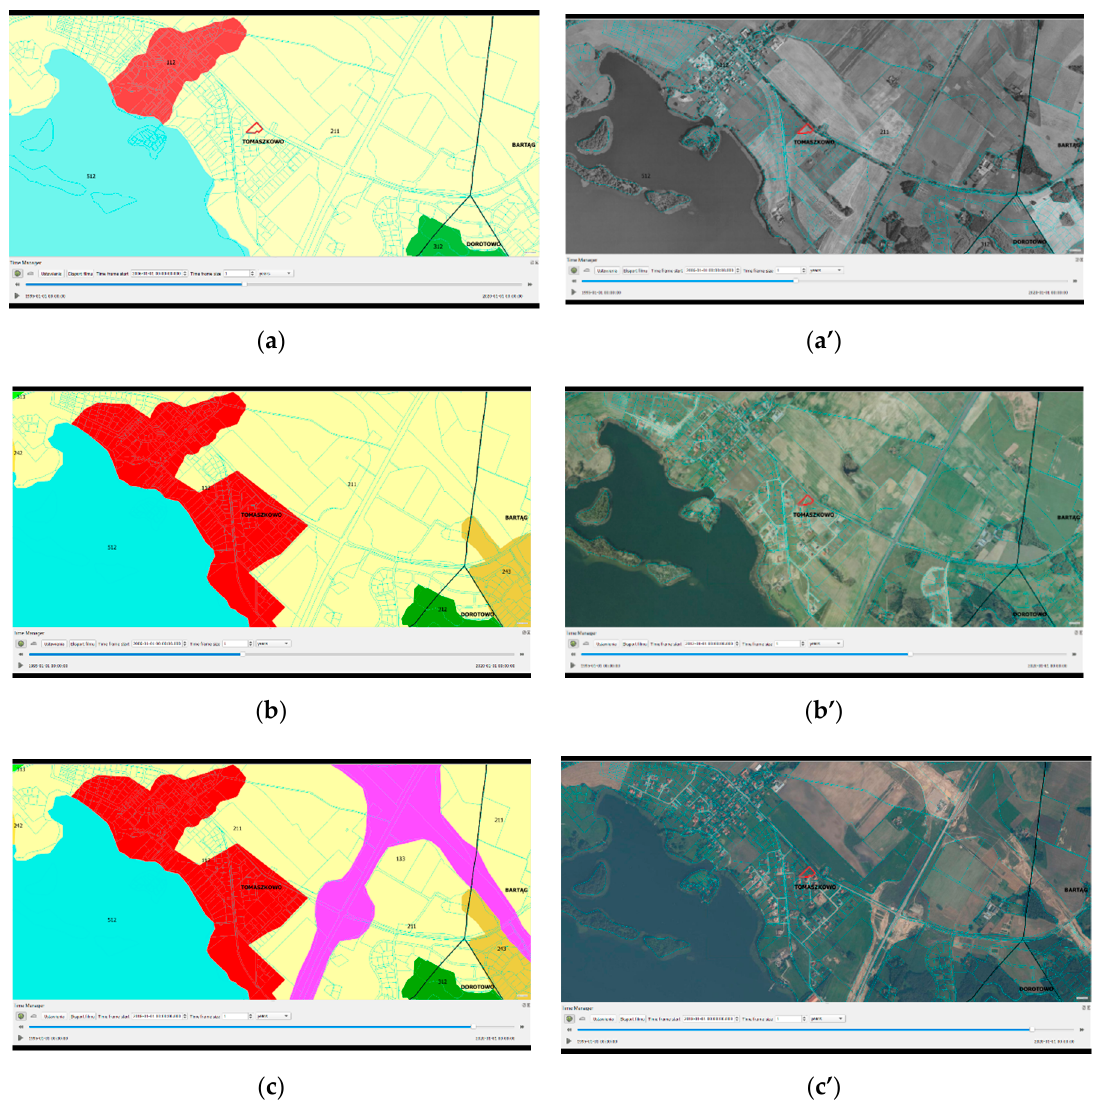
Figure 4. Comparison of information on land cover according to Corine Land Cover (CLC) data from the ( a ) year (2006); ( b ) 2012; ( c ) 2018 and orthophotos (www.geoportal.gov.pl) from the year ( a’ ) 2006; ( b’ ) 2012; ( c’ ) 2018. Source: [54–56].